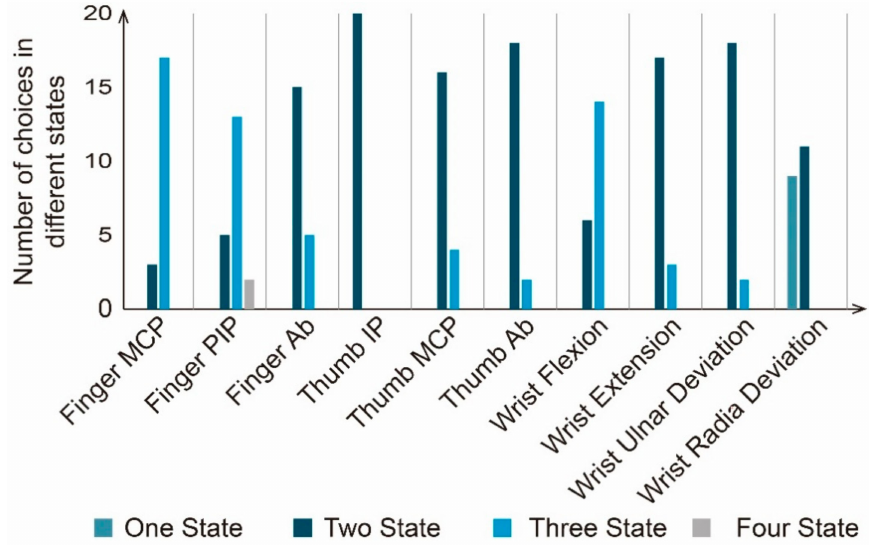
Figure 11. The number of motion primitive unit semantic expression states given by the participants. Gesture Execution Measurement Results of Each State of the Motion Primitive Unit unit, the execution data of the corresponding typical gestures were measured and